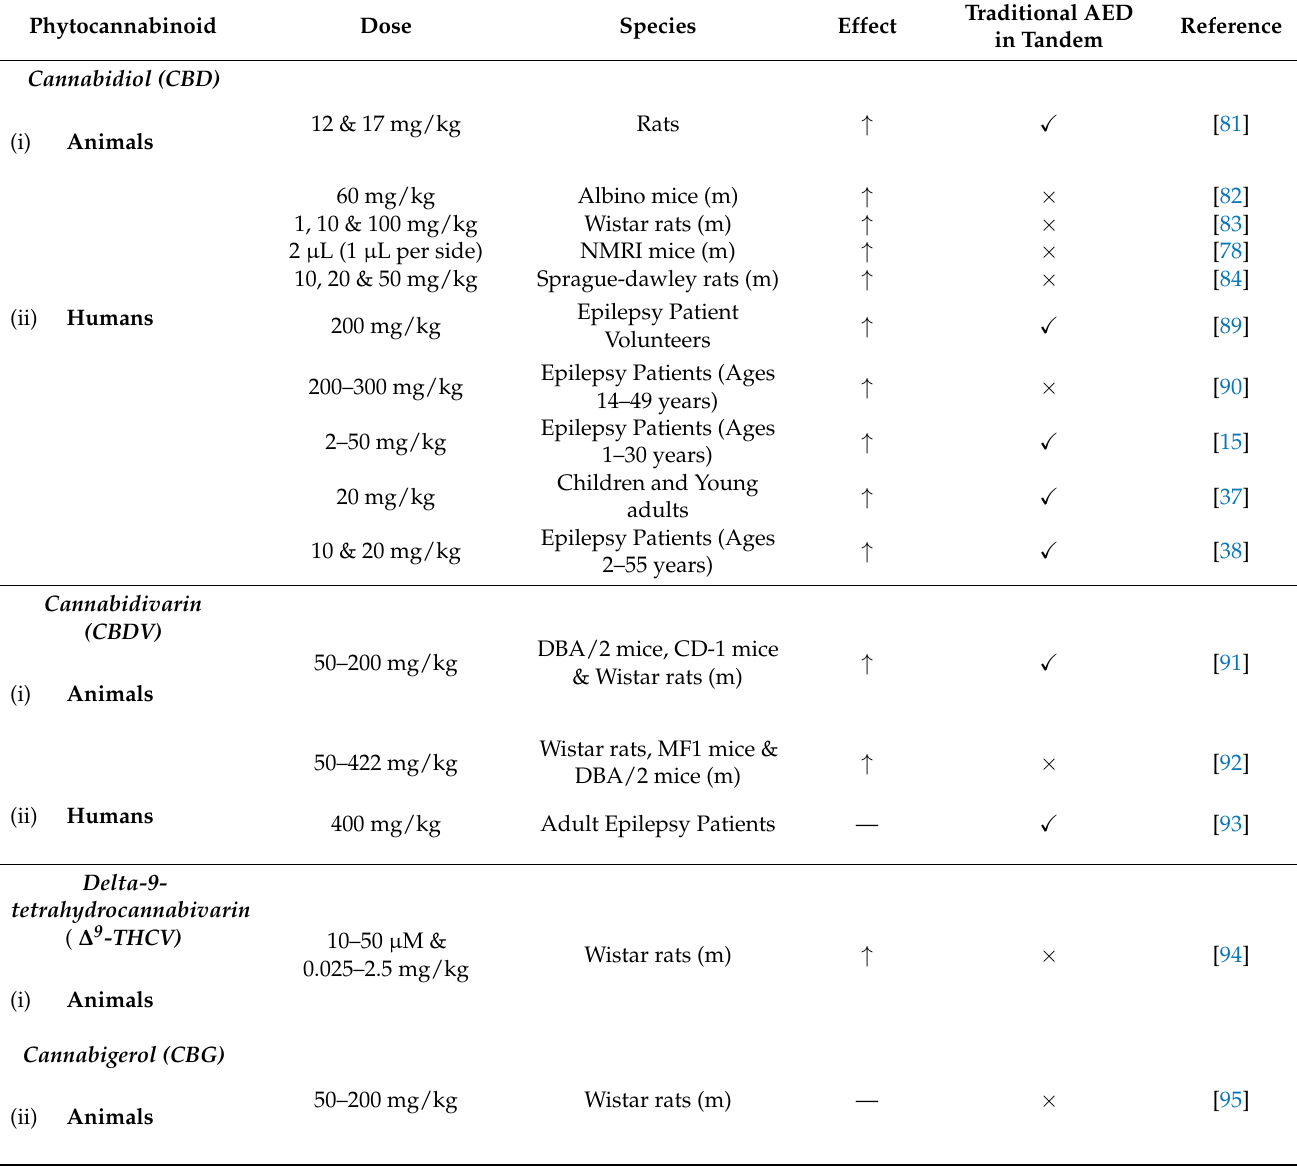
Traditional AED in Tandem